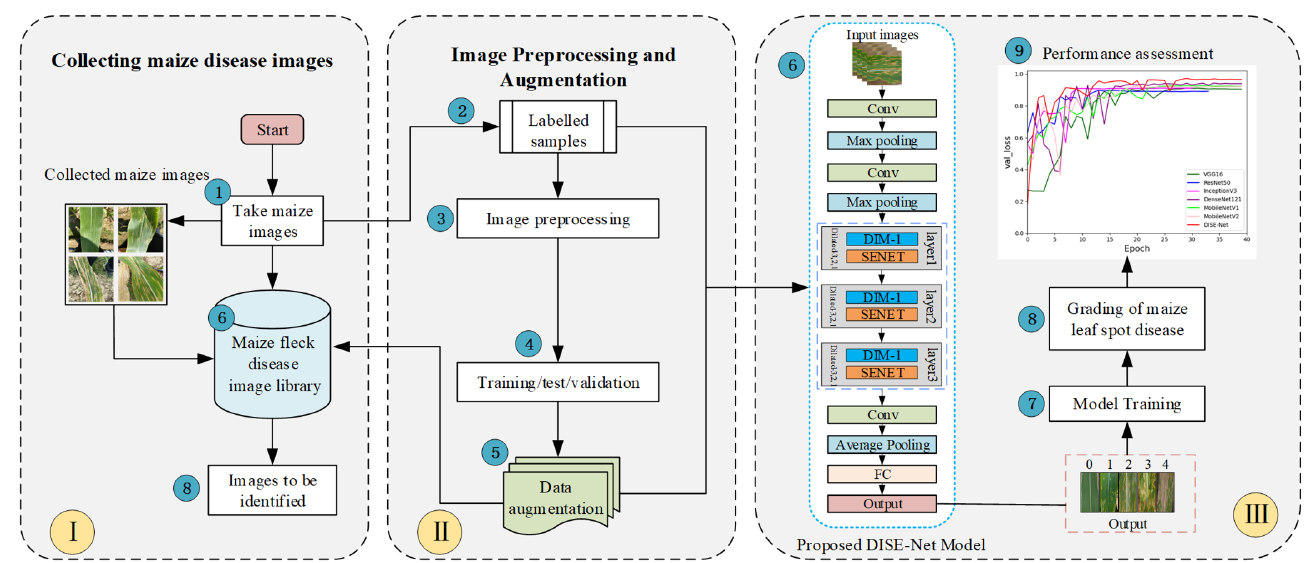
Figure 10. Whole process of grading detection of maize small leaf spot disease.